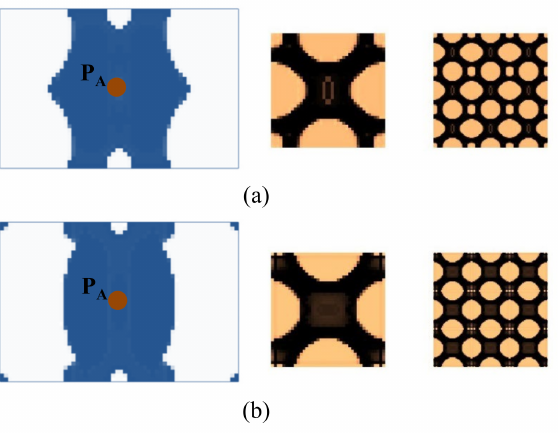
Figure 23. Design results obtained at the same excitation position P A and different excitation fre-